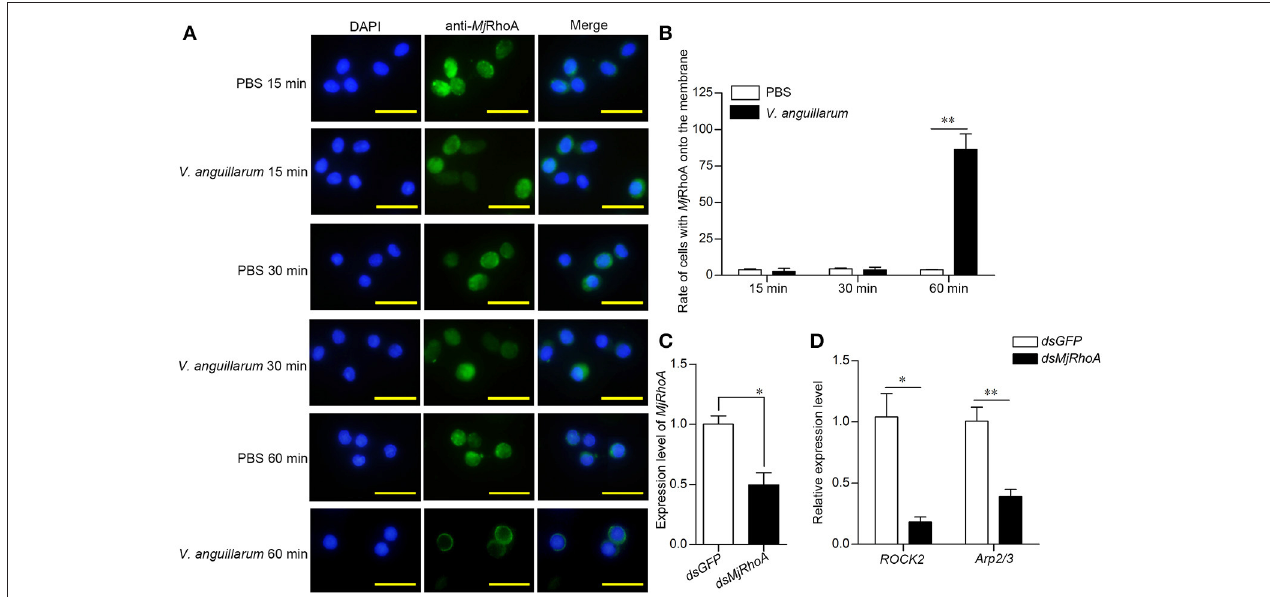
FIGURE 4 | Mj RhoA transfers to the cell membrane and regulates phagocytosis related genes after bacterial challenge. (A) The location of native Mj RhoA in hemocytes, detected using immunocytochemistry. Normal shrimp were injected with 50 µ L V. anguillarum (10 7 cells per shrimp) and the same volume of PBS for 1h, separately. The Mj RhoA location in vivo was detected using anti- Mj RhoA antiserum. The nuclei were stained with DAPI. The location of Mj RhoA in PBS-injected shrimp hemocytes was used as a control. Scale bar = 20 µ m. (B) The proportion of hemocytes with Mj RhoA on the cell membrane among the total cells among shrimp challenged by V. anguillarum at different time points. Shrimp injected with PBS was used as a control. (C) The RNAi efficiency of MjRhoA after knockdown for 48h. Shrimp injected with dsGFP were used as a control. (D) The expression level of phagocytosis-related genes was detected using qPCR after knockdown of MjRhoA . Two genes, ROCK2 and Arp2/3 , were chosen to detect phagocytosis. DsGFP injection was injected as a control. * p < 0.05, ** p < 0.01.